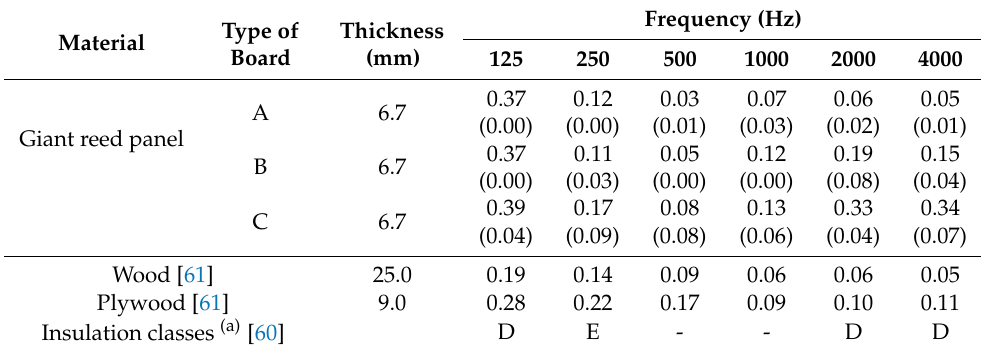
Table 6. Sound absorption coe ffi cients ( α ) according to